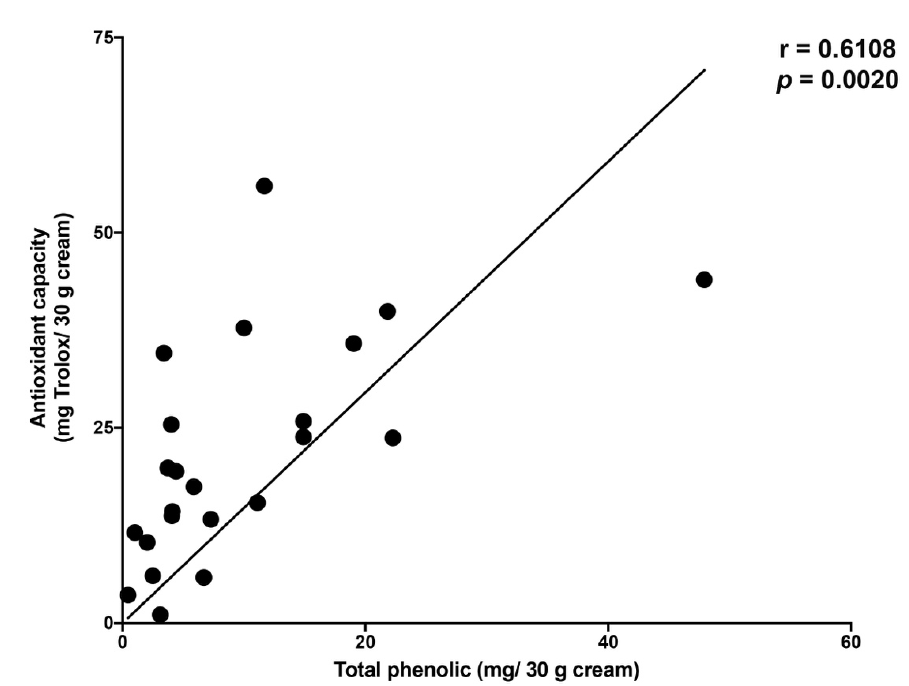
Figure 2. Scatter plot and Pearson’s correlation coefficient (r) for the relationship between total phenolic content and antioxidant capacity of 23 cream products on the Thai market.